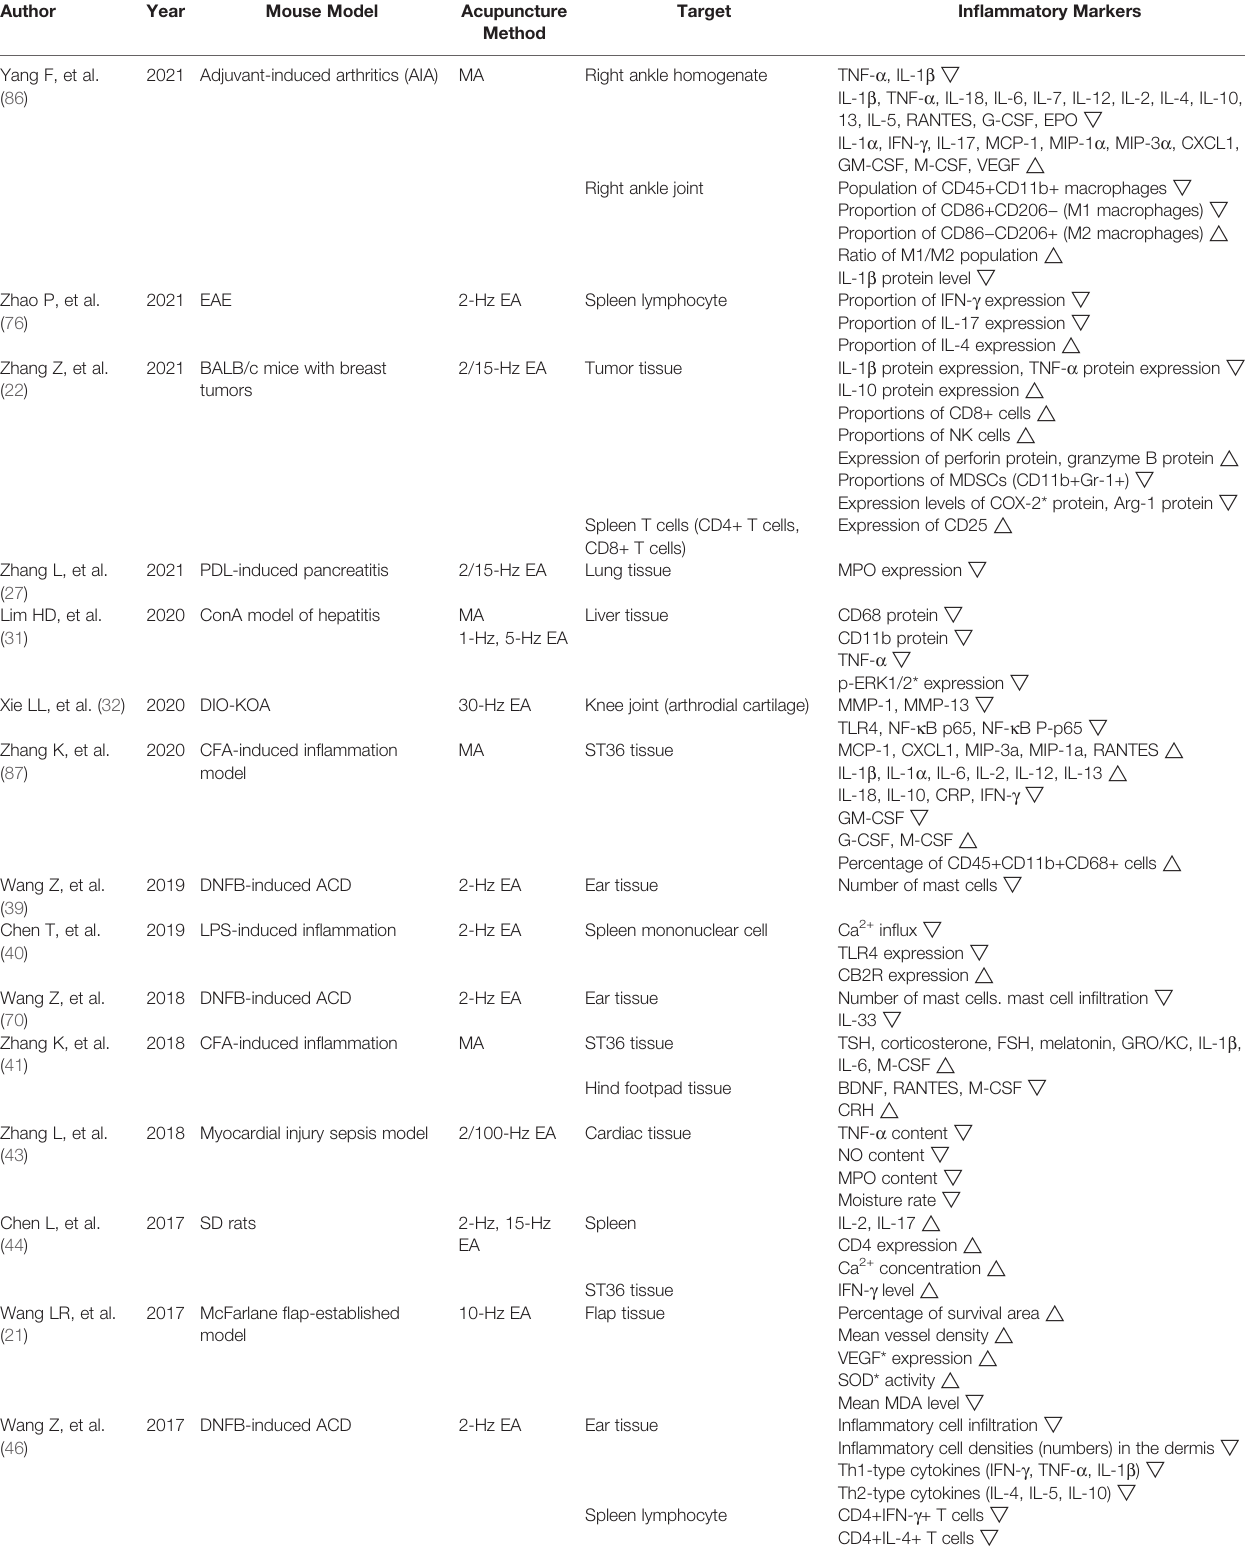
TABLE 4 | Anti-in fl ammatory effect of acupuncture on ST36 in